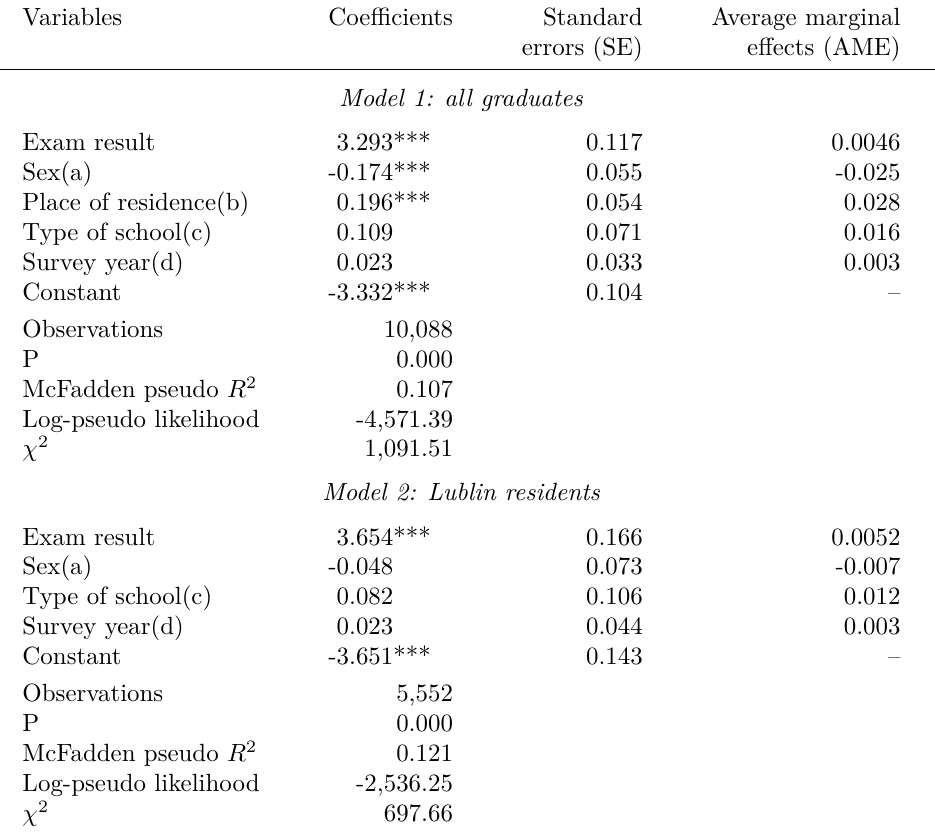
Table 3: Logit regression model results for total emigration from the